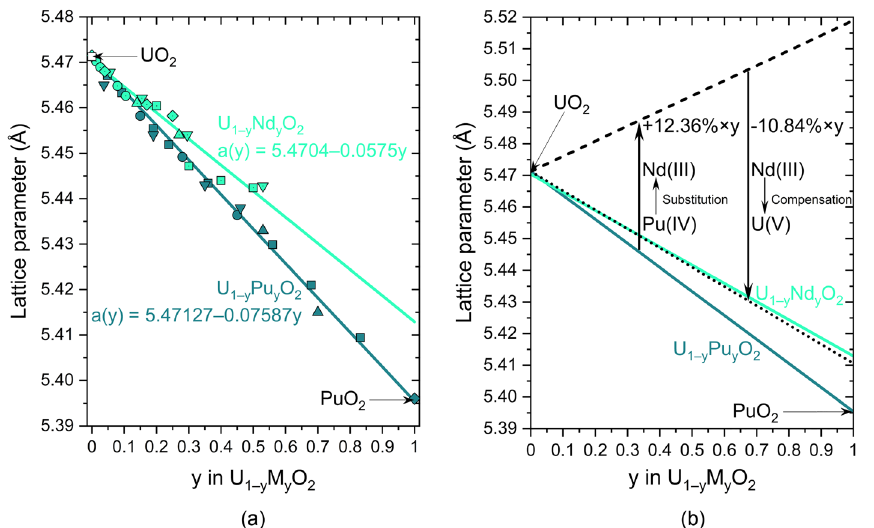
Figure 3. ( a ) Variations in the experimental lattice parameters of U 1−y M y O 2 at room temperature as a function of y with M=Pu or Nd. The symbols correspond to the experimental data at room temperature, and the lines to their linear regression as a function of y (Vegard’s law). ( b ) Comparison of experimental (solid lines) and calculated lattice parameters from the tabulated ionic radii without (dashed line) and with (dotted line) the Nd(III)/U(V) compensation mechanism. N.B. the fit of a U 1 Nd y O 2 (cid:31) y (cid:30) was extrapolated to y = 1 for the − y discussion, even if the fluorite structure is not maintained at high Nd